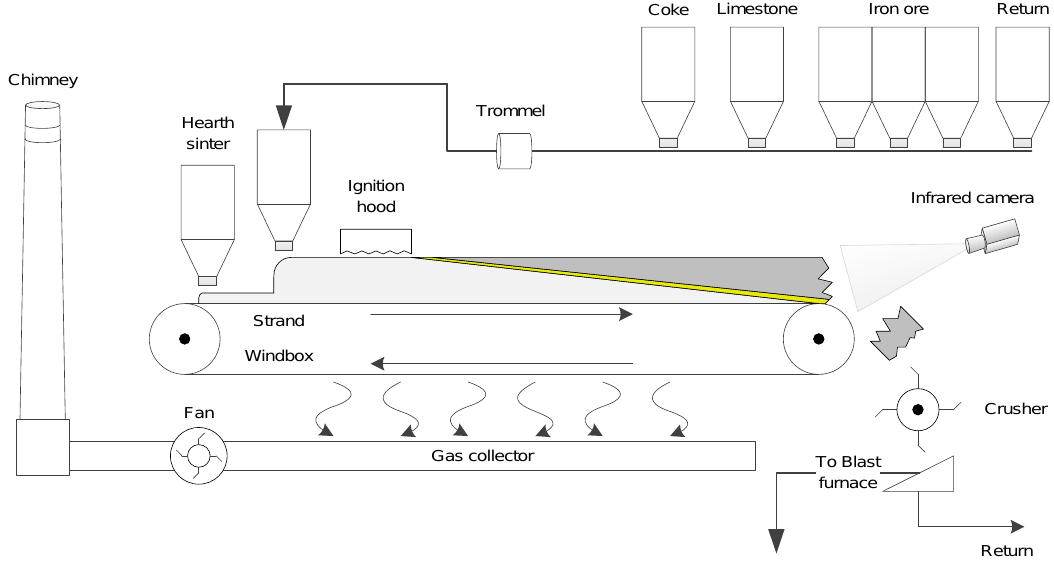
Figure 1. Sintering process using a Dwight-Lloyd